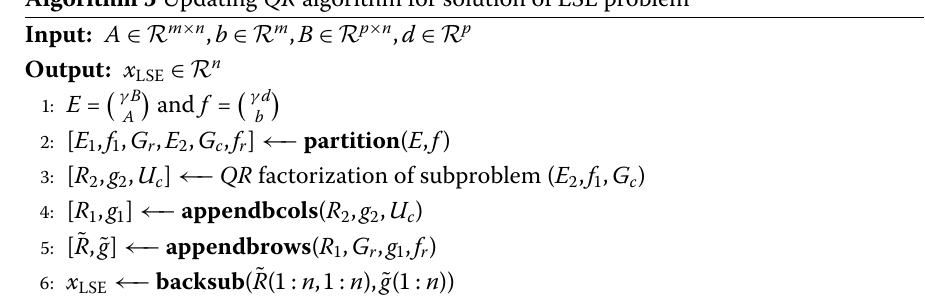
Algorithm  Updating QR algorithm for solution of LSE